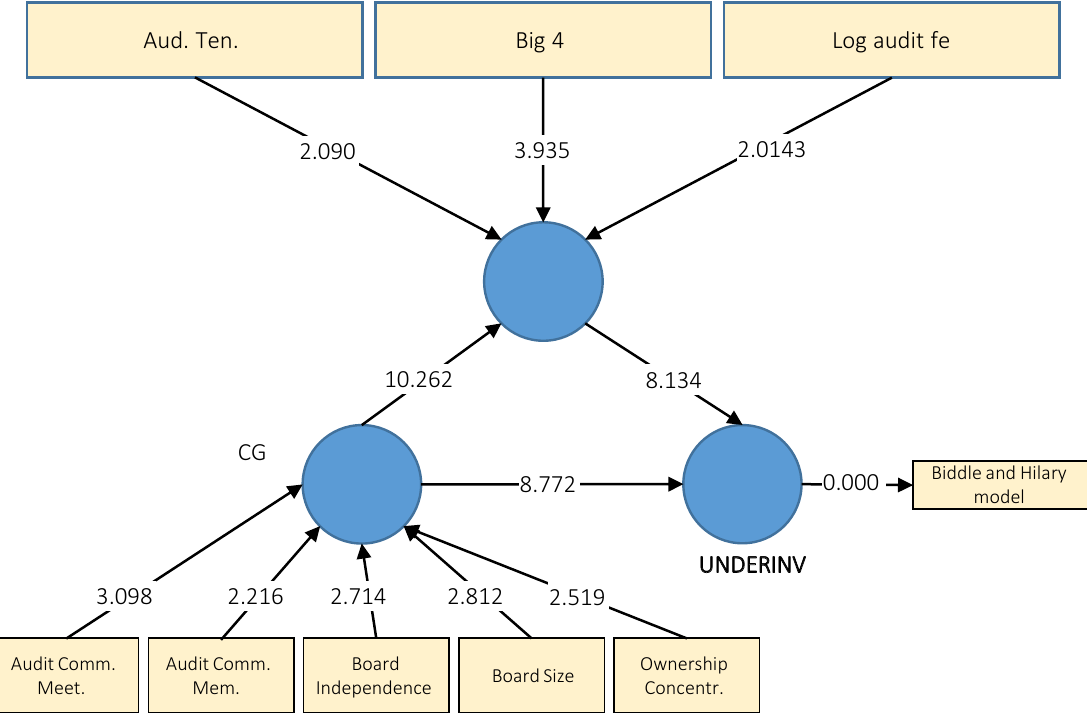
Figure 5. Measurement model (inner model), UNDERINV model